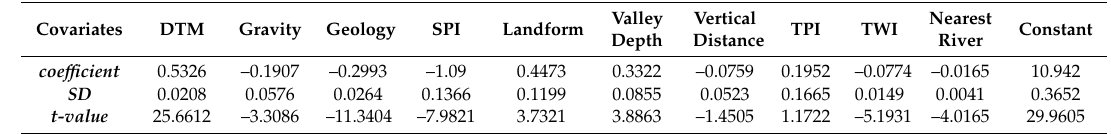
Table 1. The calculation results of the coe ffi cients by involving the entire dataset and all the parameters (estimation 1). Digital terrain model (DTM); slope position index (SPI); topographic positional index